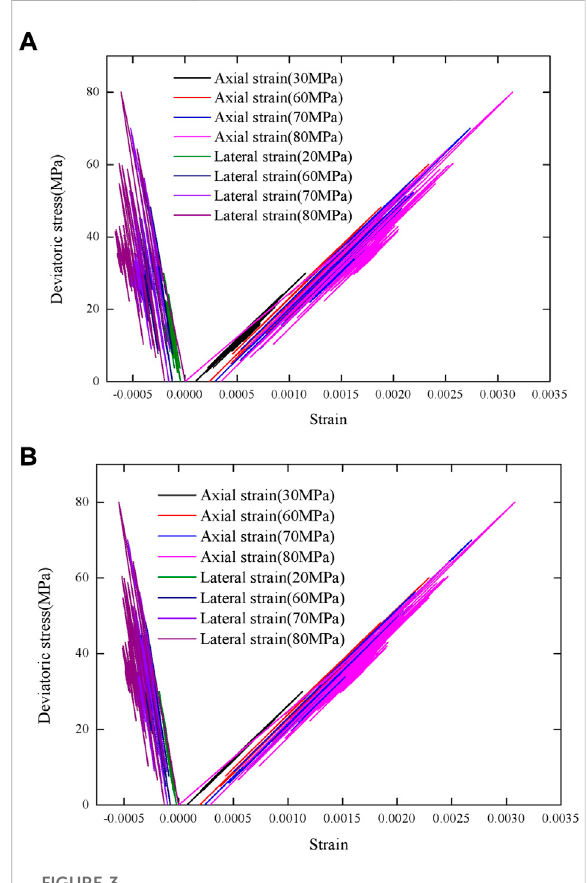
FIGURE 3 The stress-strain curves of the rock under Kobe seismic load with different maximum stresses: (A) Uniaxial loading; (B) Triaxial loading with con fi ning pressure of 15